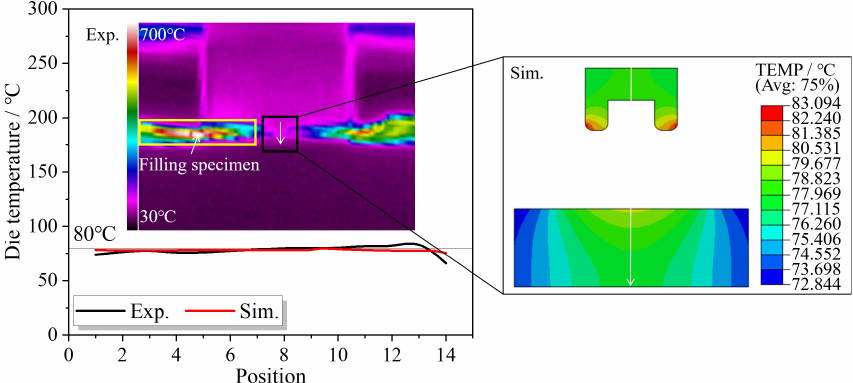
Figure 11. Comparison between simulated temperature distribution and experimental results.